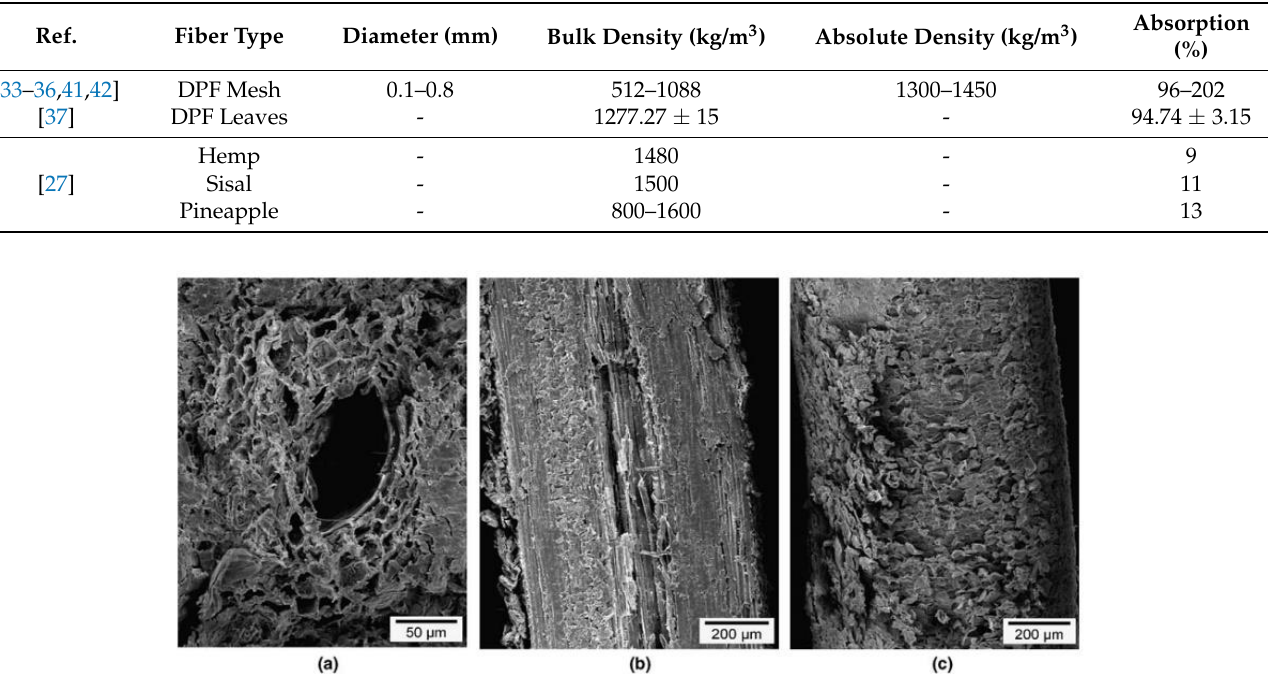
Figure 2. SEM of DPF mesh, ( a ) transversal section; ( b ) longitudinal section; ( c ) longitudinal view [35]. Table 3. Physical properties of DPF compared to other agricultural fibers. Ref.